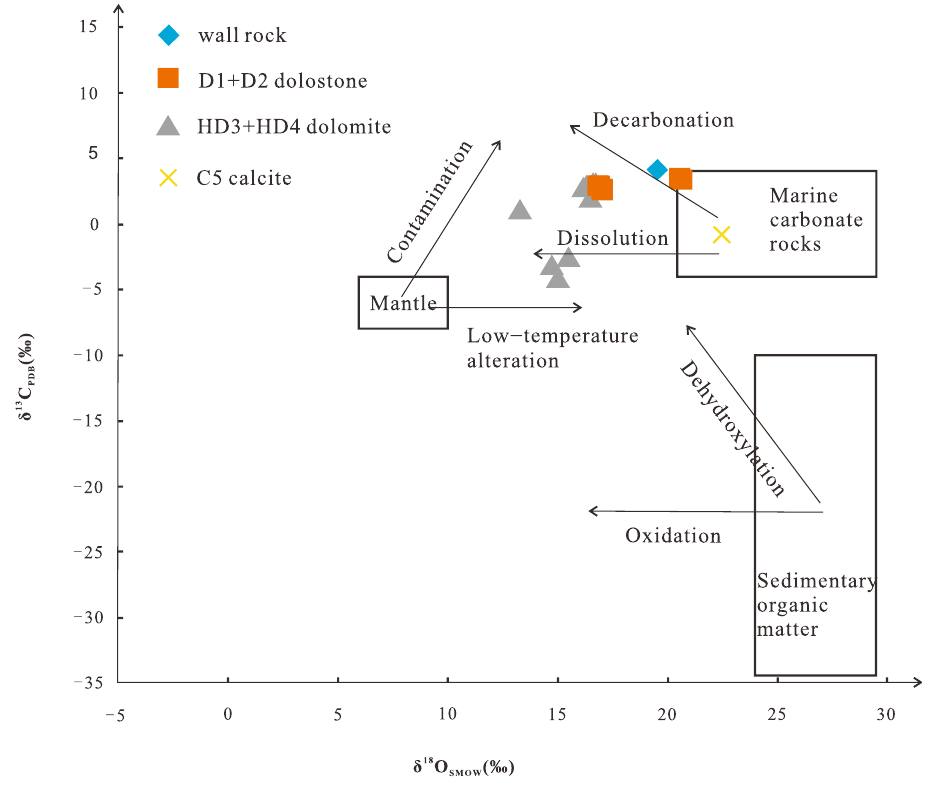
Figure 9. C vs. O isotopic compositions of carbonates from the Fuli Pb-Zn deposit (modified from Zhou et al., 2018).